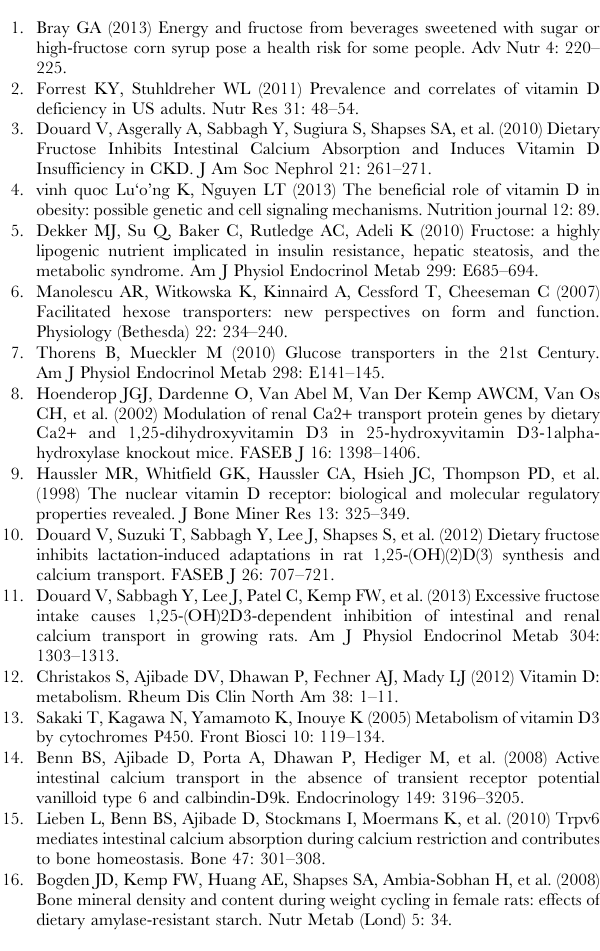
Figure S5 mRNA levels of GLUT5. Expression level of GLUT5 in the intestine of A ) mice fed diets containing either 43% glucose or fructose, in combination with either normal or low Ca 2 + for 5 wk; B ) mice fed diets containing normal Ca 2 + in combination with 63% glucose, fructose or starch for 3 mo; and C ) rats fed diets containing either 43% glucose or fructose for 3 mo. All expression data were analyzed by real-time PCR using EF1 a as a reference and normalized relative to levels seen in rat fed glucose diet. Nor = normal; G = glucose; F = fructose. Data are means 6 SEM ( n = 6 per group). Differences ( P , 0.05) among means are indicated by differences in superscript letters, as analyzed by 1-way ANOVA LSD. Thus, for each study, bars with superscript ‘‘a’’ are . bars with ‘‘b’’. Table S1 Primer sequences